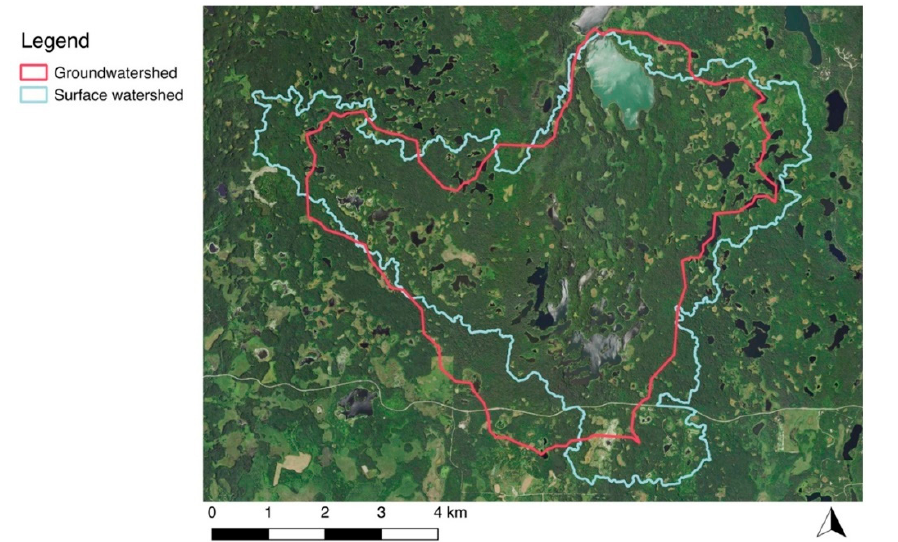
Figure 11. Surface watershed (light blue outline) and groundwatershed (red outline) delineated for Elk Lake.